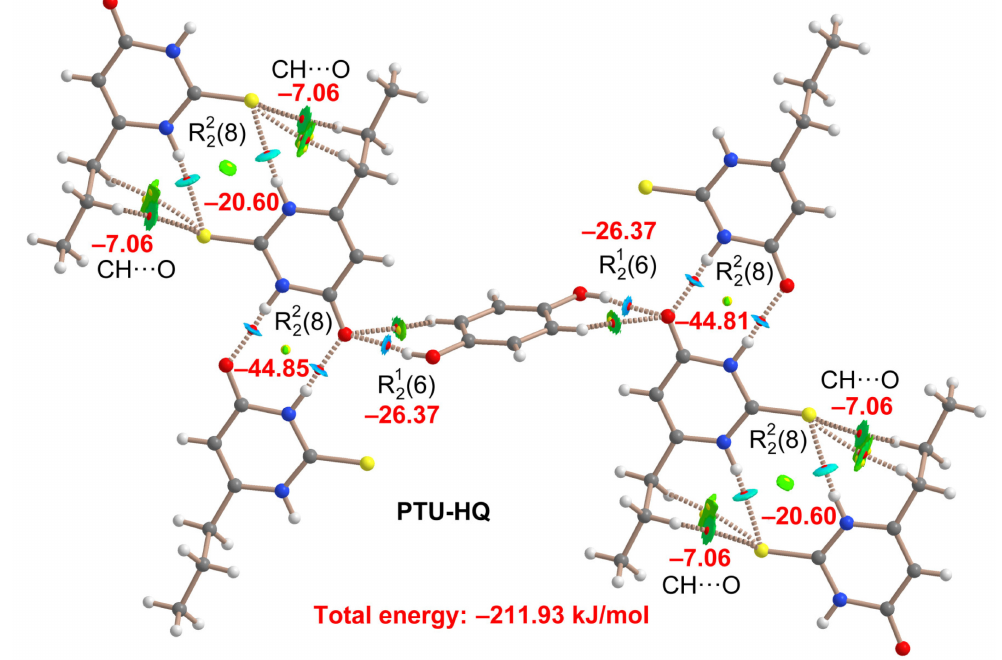
Figure 11. QTAIM/NCIPlot analysis of intermolecular bond and ring CPs (red and yellow spheres, respectively), bond paths, and RDG isosurfaces of the H-bonded assembly of PTU–HQ cocrystal. The individual association energies of each synthon or CH ··· O H-bond are indicated using a red font inside the supramolecular rings or adjacent to the CH ··· O